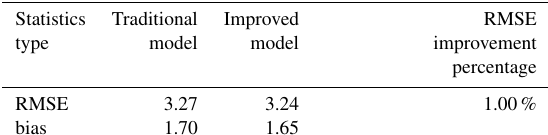
Table 4. Statistics of two models’ tomography accuracy with re- spect to ECMWF data in the rainy scenario and the non-rainy sce- nario for the experimental period (unit: gm − 3 ).